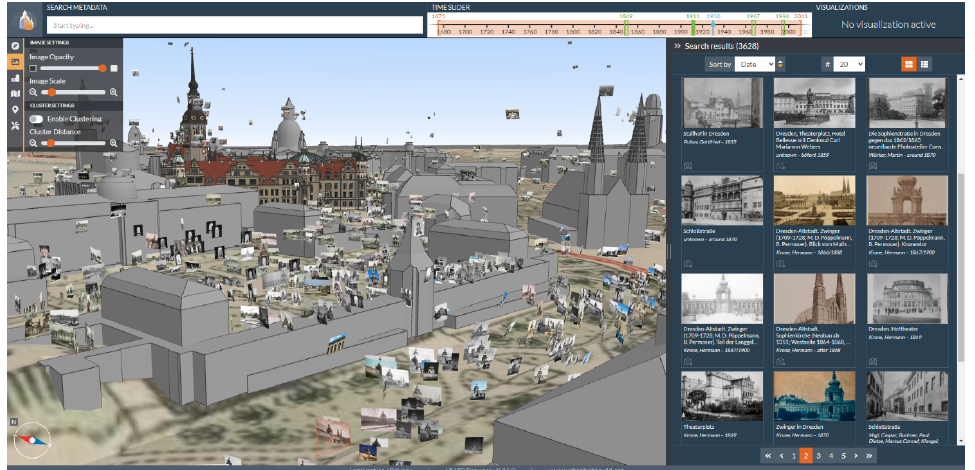
Figure 1. Graphical user interface of the 4D browser showing the 3D city model of Dresden, Germany, and spatially oriented